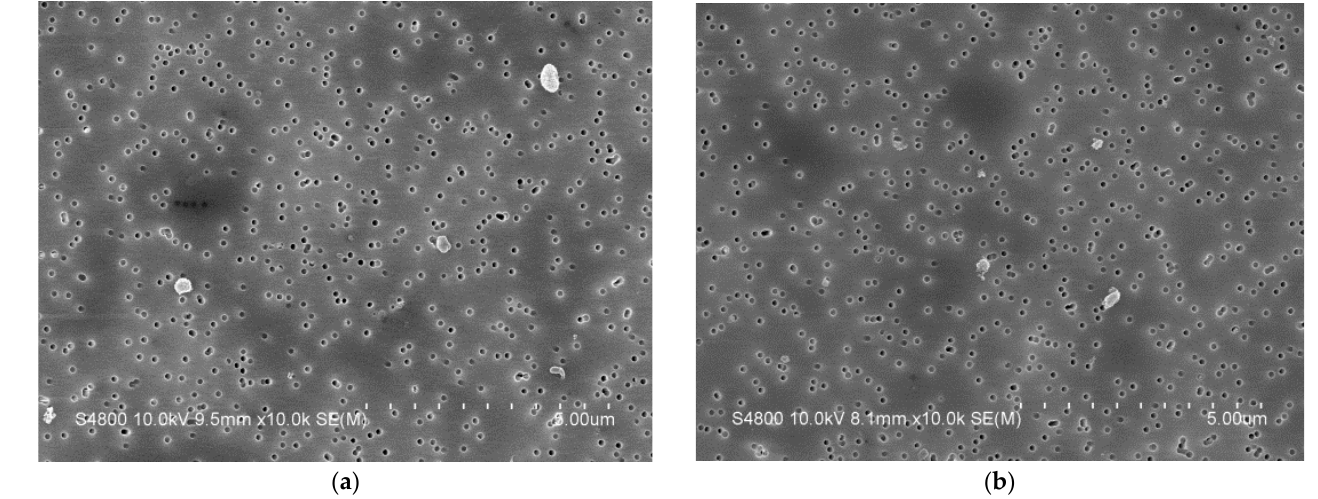
Figure 3. Image of polyethylene wear particles on filter membrane with pore size of 0.1 μ m: ( a ) unaged; ( b ) aged.